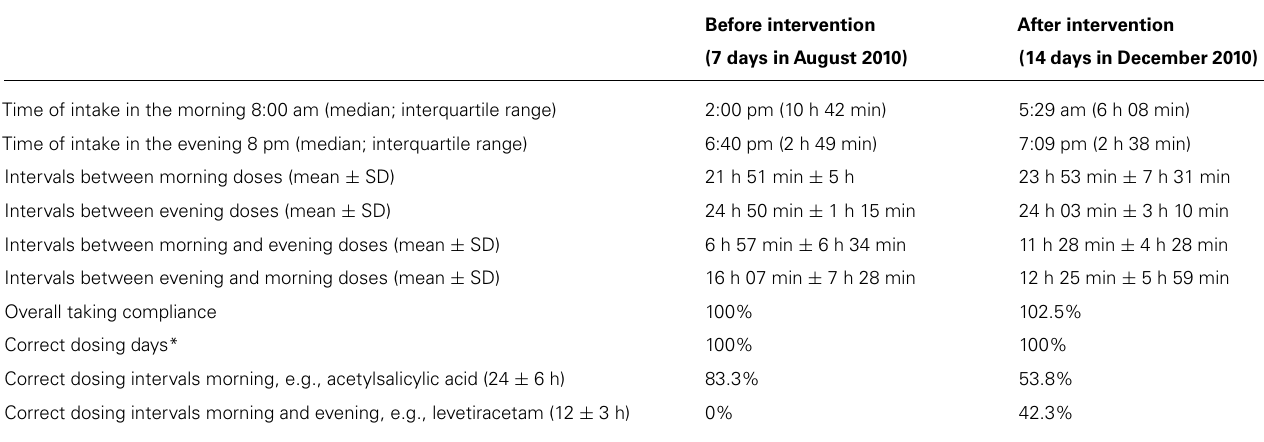
Before intervention After intervention (7 days inAugust 2010)